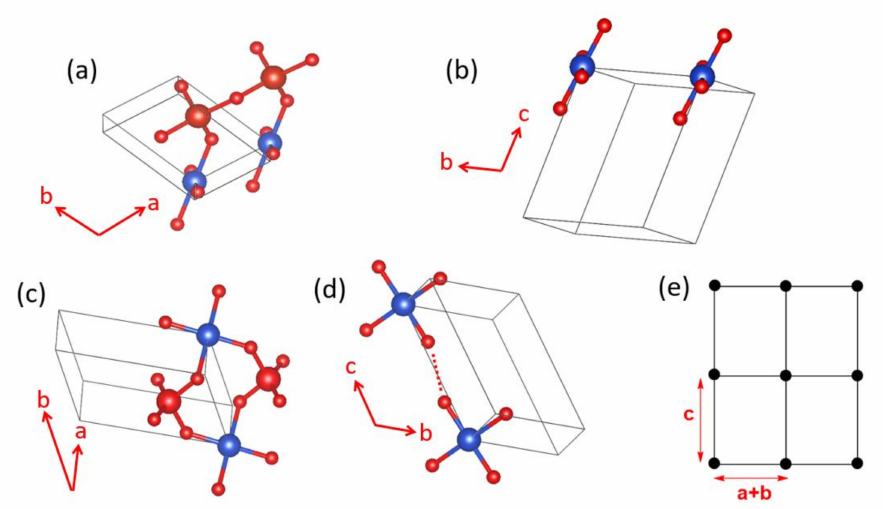
Figure 12. Spin exchange paths and spin lattice of α -CuV 2 O 6 : ( a ) Spin exchange along the b-direction, J b ; ( b ) Spin exchange along the c-direction, J c ; ( c ) Spin exchange along the a-direction, J a ; ( d ) Spin exchange along the (a + b)-direction, J a+b ; ( e ) Rectangular spin lattice made up of J c and J a+b